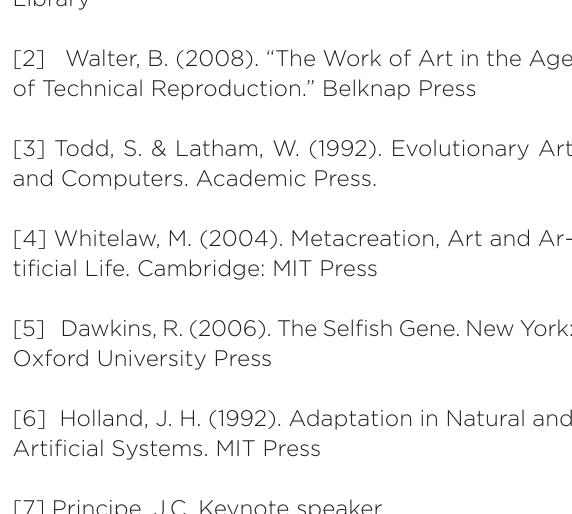
Fig. 5. Untitled* at Serralves on 30 th July 2009 (cid:1)